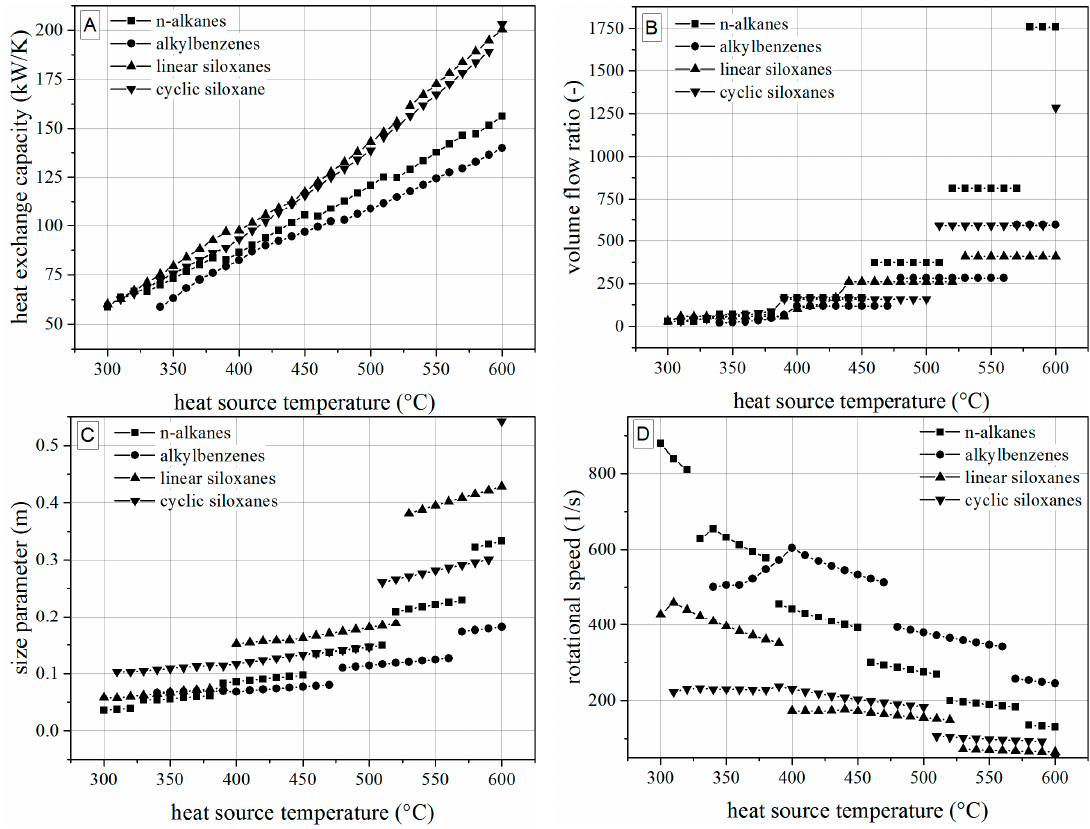
Figure 7. Heat exchange capacity ( A ), volume flow ratio ( B ), size parameter ( C ) and rotational speed ( D ) depending on the heat source temperature.